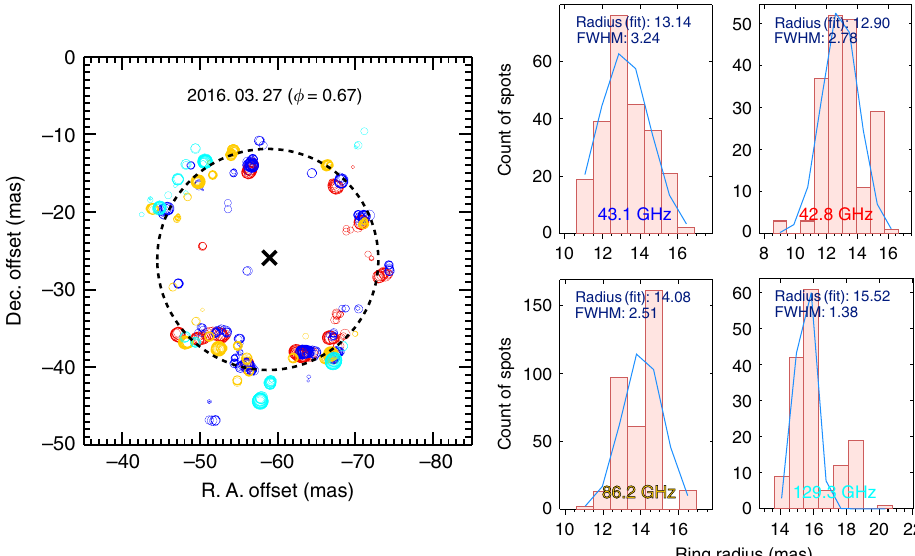
Fig. 3 Registered maps of the SiO maser spots and the histograms of their radial distributions. The blue, red, yellow, and cyan colors indicate 43.1, 42.8, 86.2, and 129.3 GHz SiO masers, respectively. The dotted circle shows the result of ring fi tting using all the maser spot distributions of the four maser lines. The mark “ x ” indicates the ring fi tting center assumed to be the position of the central star. Histograms represent the radial distribution of the maser spots with respect to the central star. The ring radius and FWHM derived from the Gaussian fi tting are represented in each panel